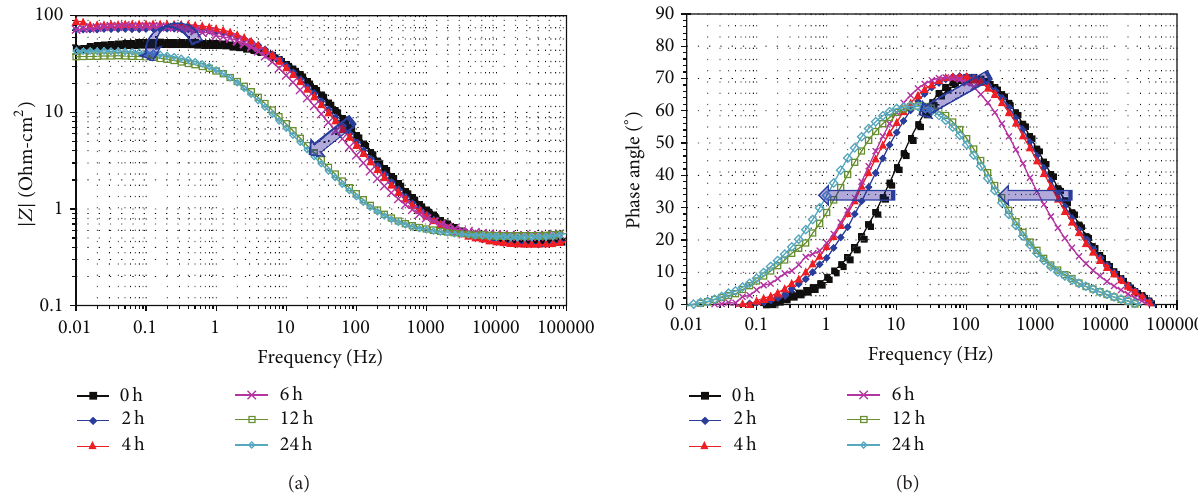
Figure 3: Bode plots in the (a) impedance module and (b) phase angle format for carbon steel in the CO 2 -saturated (3% NaCl + diesel) solution without inhibitors at 50 ∘